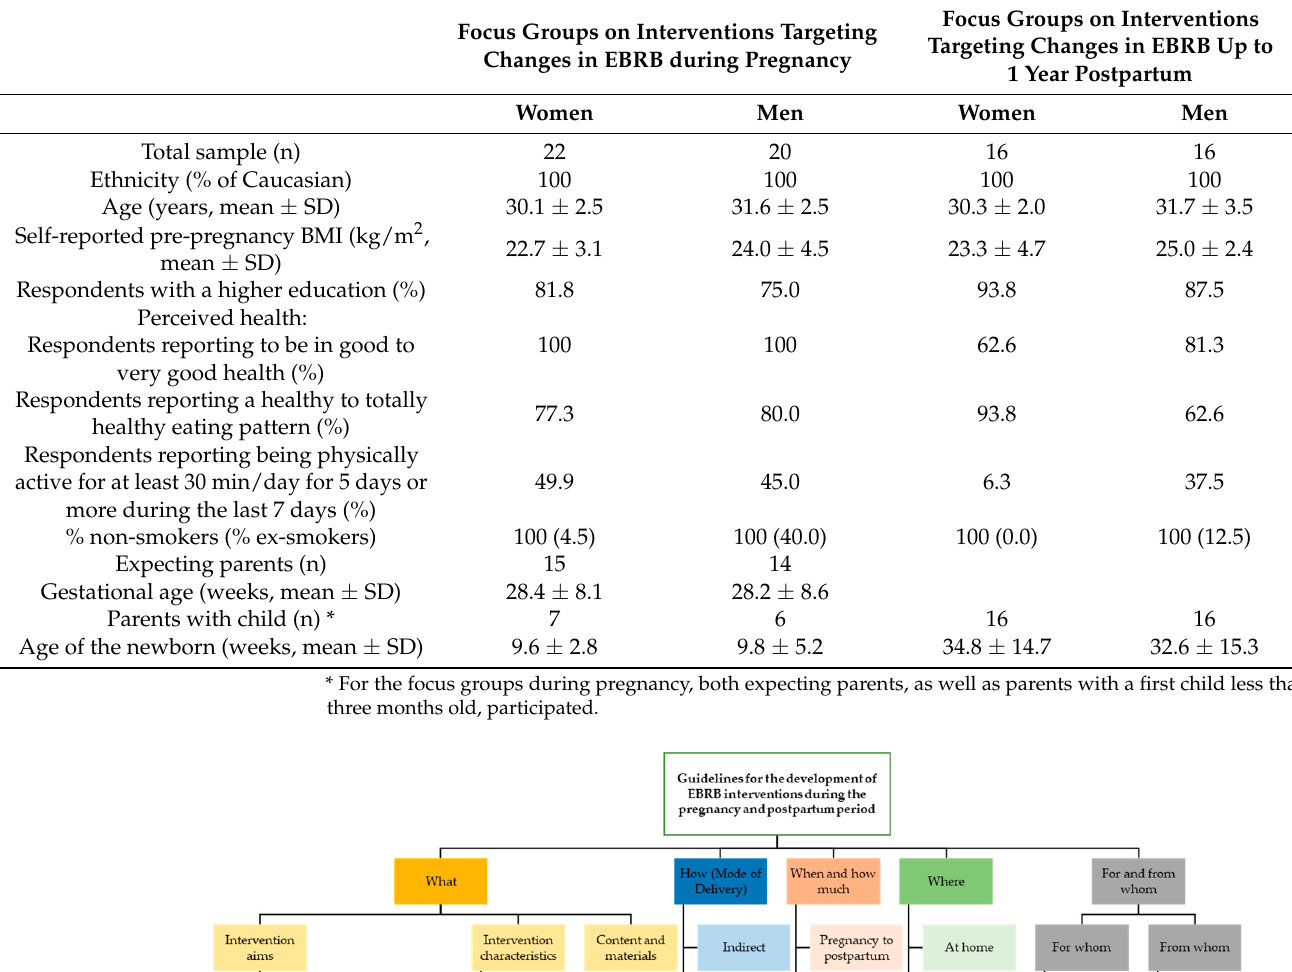
Table 2. Characteristics of the participants.